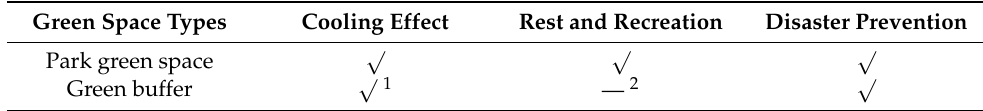
Table 1. Services provided by different types of urban green